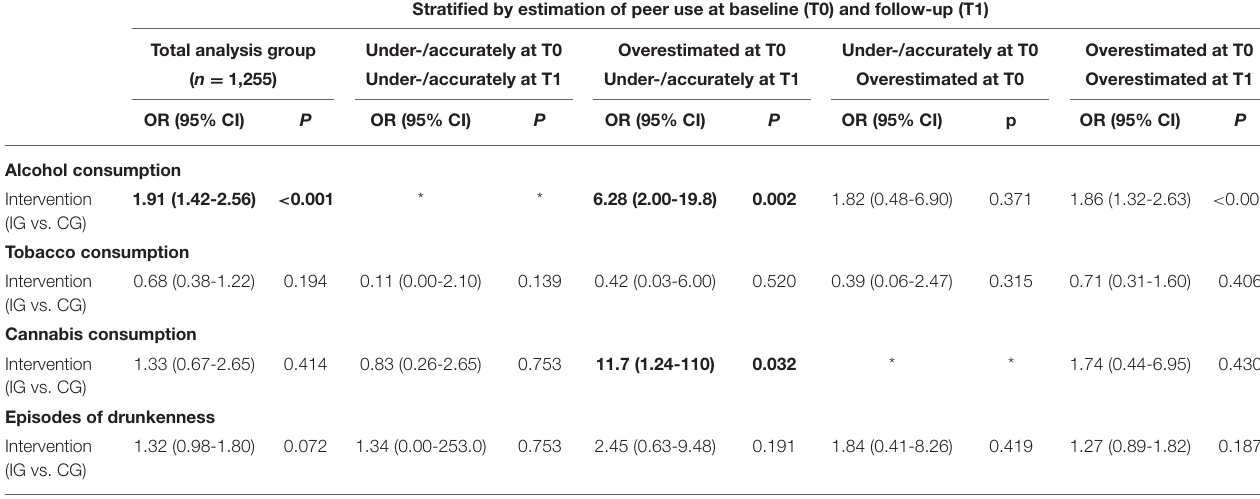
TABLE 4 | Results of multivariable logistic regression models (total and stratified); Outcomes: alcohol, tobacco, cannabis consumption, and episodes of drunkenness decreased 5 months post-intervention. Stratified by estimation of peer use at baseline (T0) and follow-up (T1) Total analysis group Under-/accurately at T0 Overestimated at T0 Under-/accurately at T0 Overestimated at T0 Under-/accurately at T1 Under-/accurately at T1 Overestimated at T0 Overestimated at T1